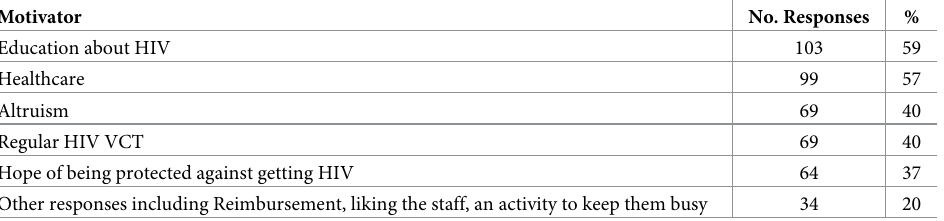
Table 3. Motivating factors for future participation in HIV Vaccine trials among 174 SiVET participants report- ing willingness to participate.